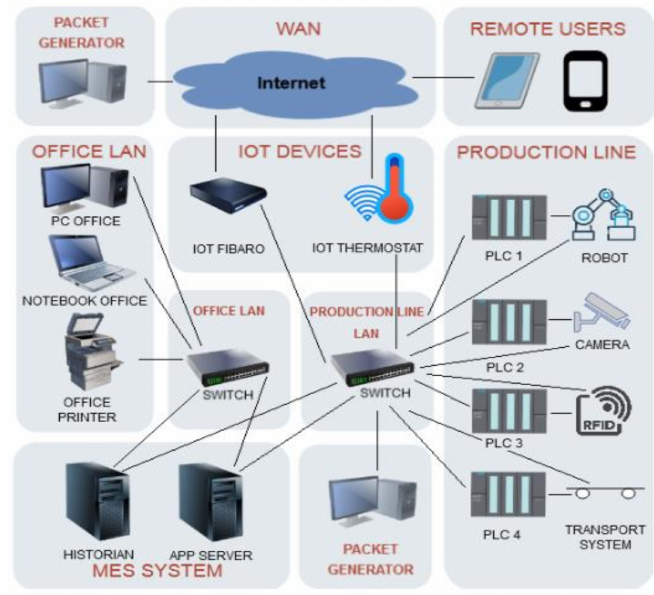
Figure 4. A real network infrastructure used in